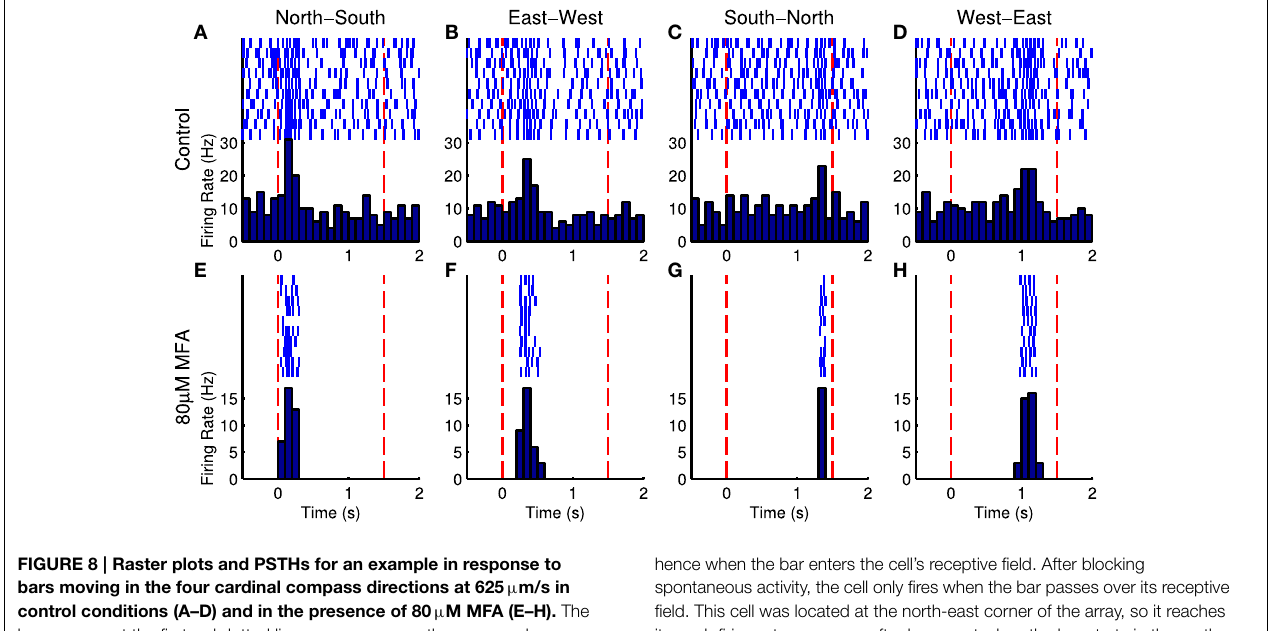
FIGURE 8 | Raster plots and PSTHs for an example in response to bars moving in the four cardinal compass directions at 625 µ m/s in control conditions (A–D) and in the presence of 80 µ M MFA (E–H). The bar appears at the first red dotted line, sweeps across the array, and disappears at the second red dotted line. On a trial-by-trial basis, random spontaneous bursts may corrupt the estimate of time to peak firing and